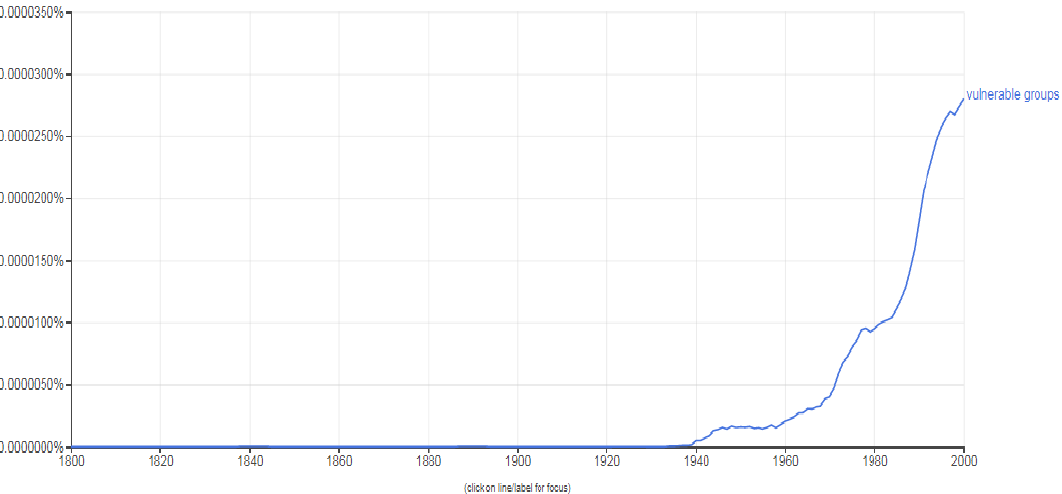
Figure 1. Vulnerable Groups.